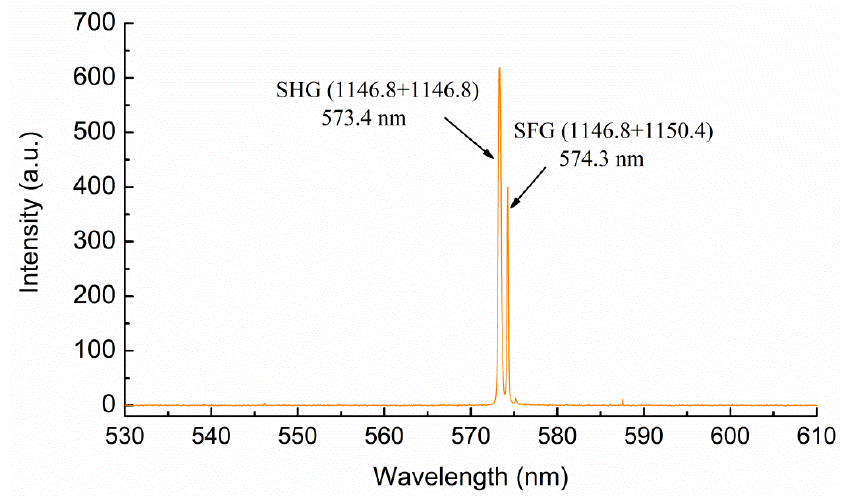
Figure 7. Spectra of weak visible light irradiated from the KTA crystal.